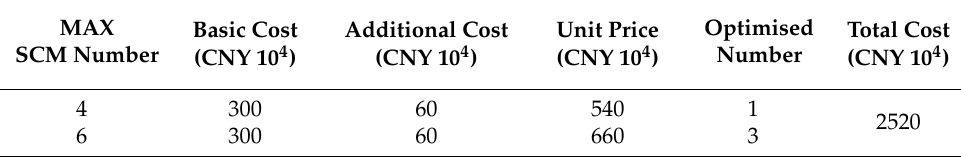
Table 3. Available SDU types and